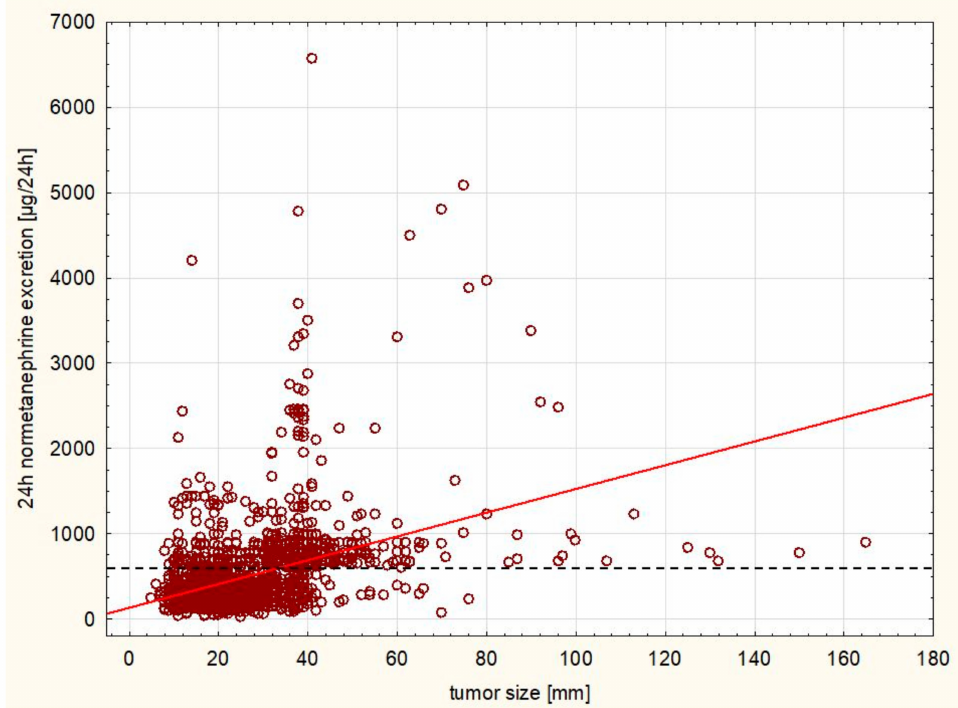
Figure 5. Positive correlation between the size of the tumor and 24 h normetanephrine excretion (r = 0.4004, p < 0.005). The cut-o ff value for normal range is marked with a dashed